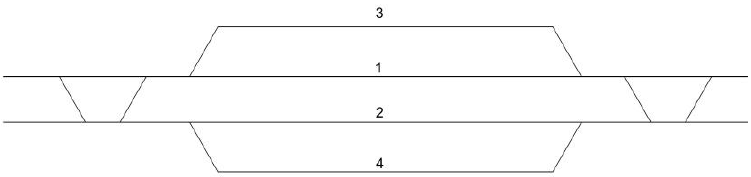
Figure 3. Track layout diagram of a small overtaking station on a double-track line. It has one siding on each of the sides of the main line and two crossovers at the two throats of the station.